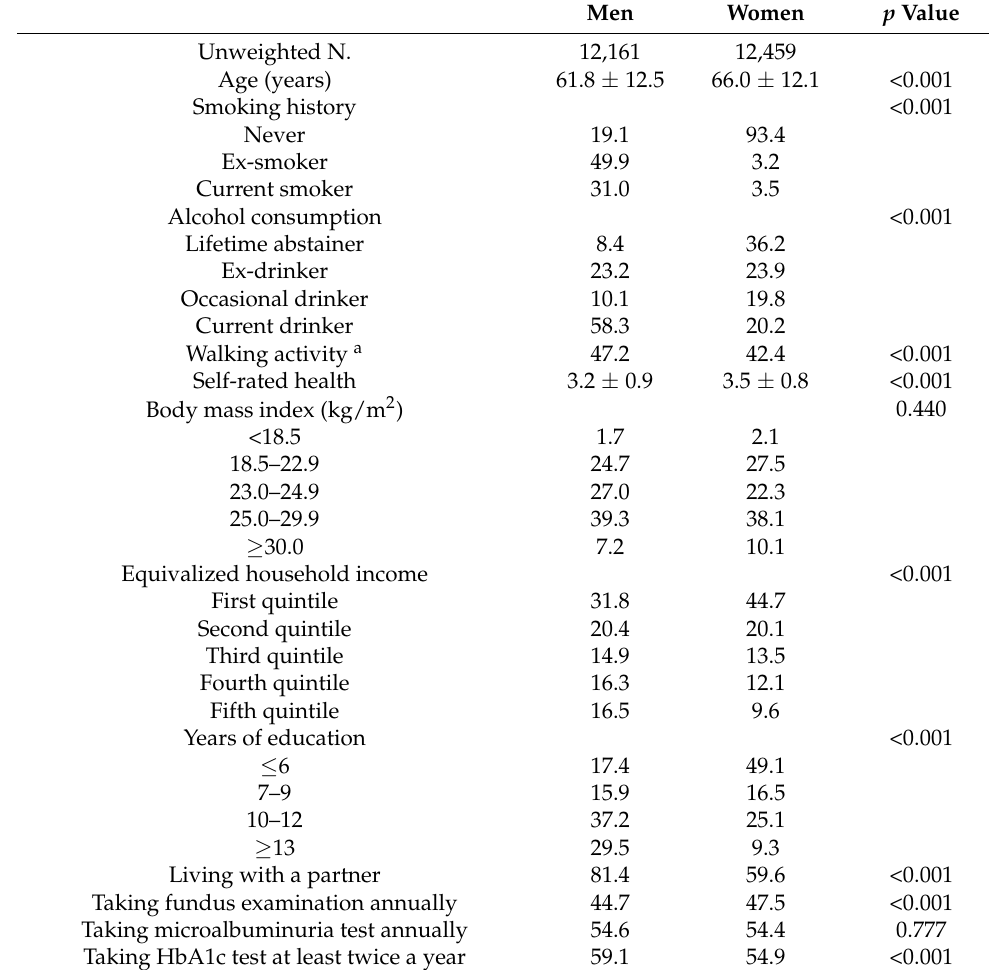
Table 1. Weighted baseline characteristics of diabetes patients in 2019 KCHS according to sex. Men Women p Value Unweighted